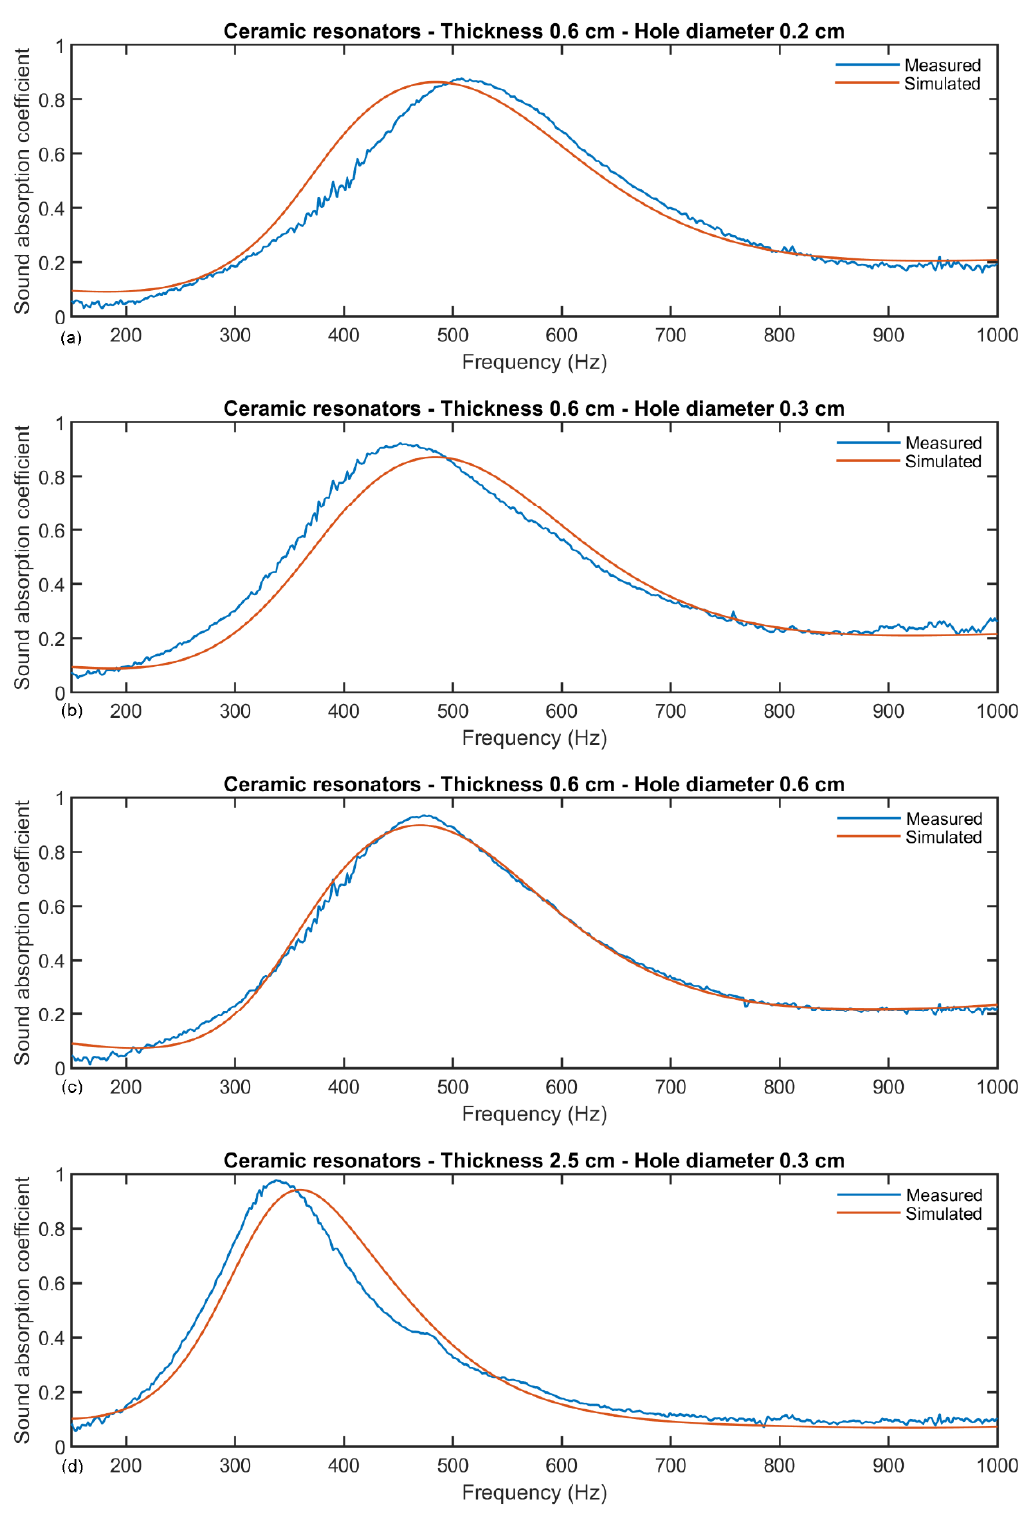
Figure 7. Comparison between the trend of the sound absorption coefficient as a function of frequency between the measurements carried out with the impedance tube and the simulations carried out with the model based on artificial neural networks: ( a ) Ceramic resonator with a thickness of 0.6 cm and hole diameter of 0.2 cm; ( b ) ceramic resonator with a thickness of 0.6 cm and hole diameter of 0.3 cm; ( c ) ceramic resonator with a thickness of 0.6 cm and hole diameter of 0.6 cm; ( d ) ceramic resonator with a thickness of 2.5 cm and hole diameter of 0.3 cm.